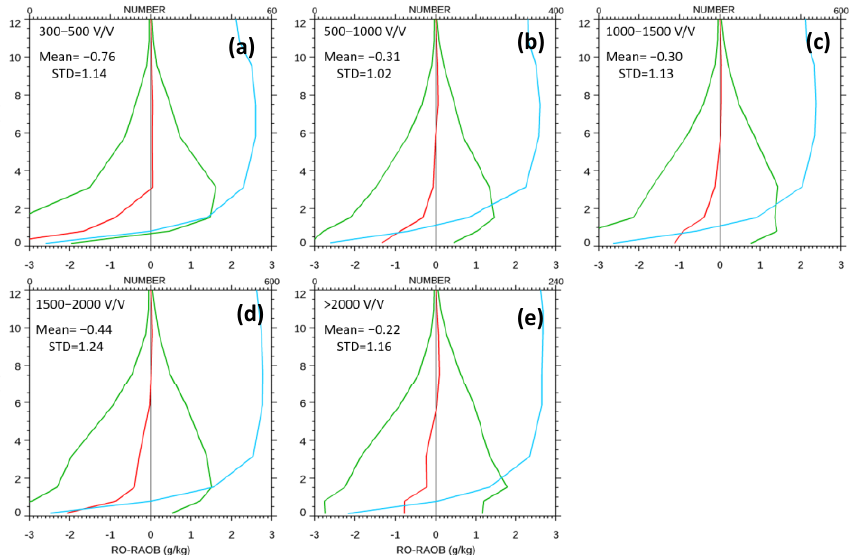
Figure 10. Monthly averaged bias (red lines) +/ − standard deviation (green lines) for (STAR-RAOB) profiles of specific humidity, and the sample numbers are in the blue lines. COSMIC-2 retrievals for October 2019 and RAOB type RS41 are used for comparison. Panels present averaging in five SNR bins ( a ) 300 – 500 V / V , ( b ) 500 – 1000 V / V , ( c ) 1000 – 1500 V / V , ( d ) 1500 – 2000 V / V , ( e ) >2000 V / V . Imposed “ Mean ” and “ STD ” values are computed by averaging from 0 km to 12 km. Table 1. Statistics of (RO-RAOB) specific humidity difference from the surface to 12 km altitudes for five SNR groups.